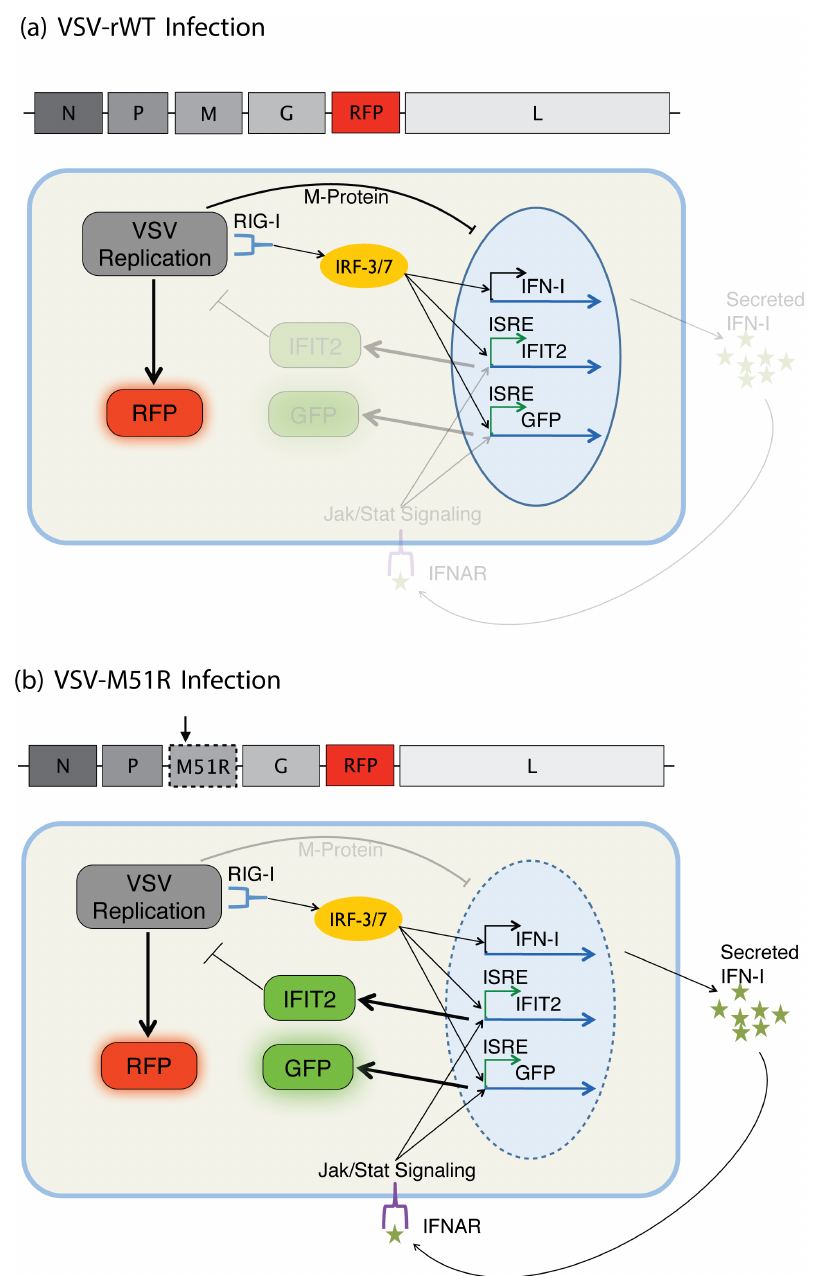
Fig 2. Infection with the recombinant VSV strains leads to the production of RFP as a reporter of viral protein production. (a) Although VSV-rWT does stimulate the early stages of immune recognition, its matrix (M) protein suppresses export of host transcripts, thereby suppressing the subsequent innate immune response and resulting in a GFP − RFP + cell. (b) The well characterized mutant of M protein, M51R [34], abolishes this function and readily stimulates the innate immune response [38]. Thus, an infection with VSV-M51R allows production of type-I interferons and activation of interferon stimulated genes, including the IFIT2 reporter, resulting in a GFP + RFP +